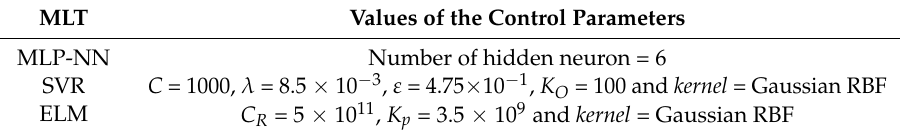
Table 5. CF-PSO optimized MLT control parameters.